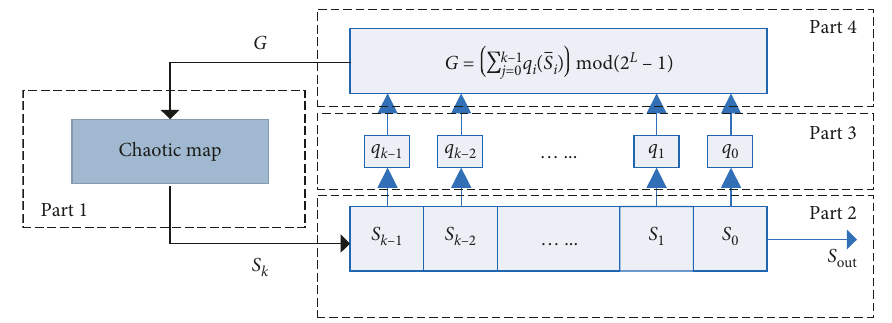
Figure 6: Structure of the